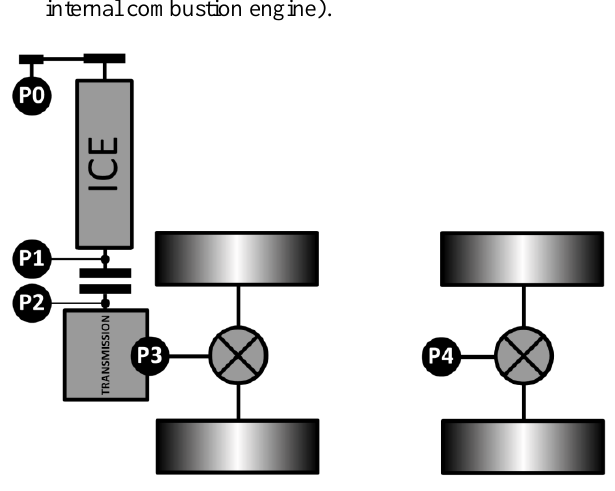
Fig. 1. Possible variants of the 48 V hybrid drivetrains in the car